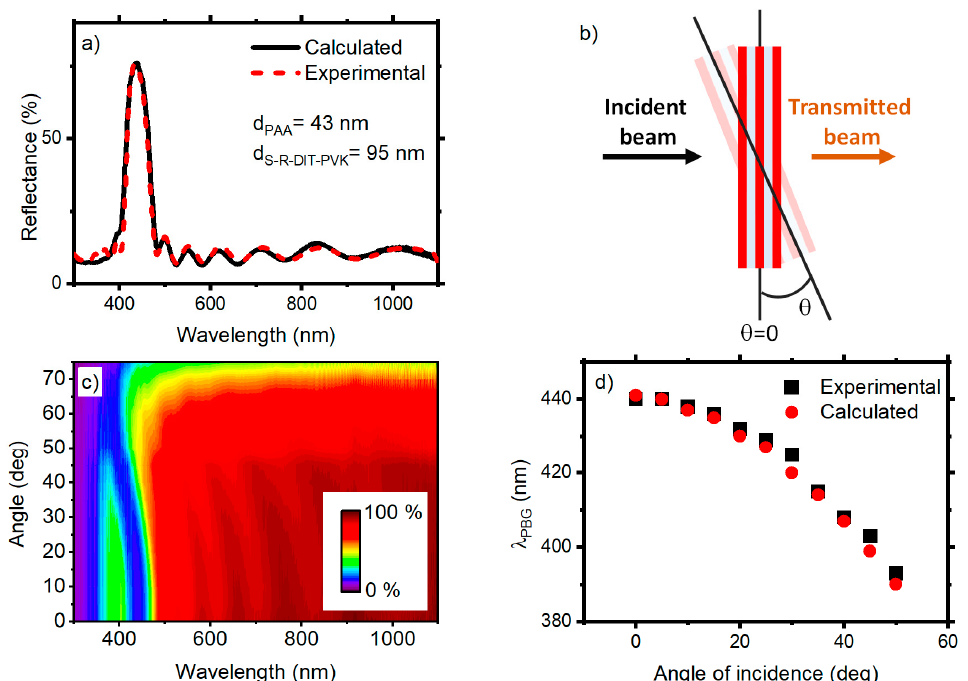
Figure 3. ( a ) Comparison between experimental and modelled normal incidence reflectance of the DBR that was made by using IVP with an initial sulfur concentration of 70 wt%; ( b ) schematic of the transmittance measurement set-up; ( c ) contour plot of the angular resolved transmittance spectra that were collected for a 10.5 bilayer DBRs; and ( d ) comparison between the experimental and theoretical spectral positions of the PBG.